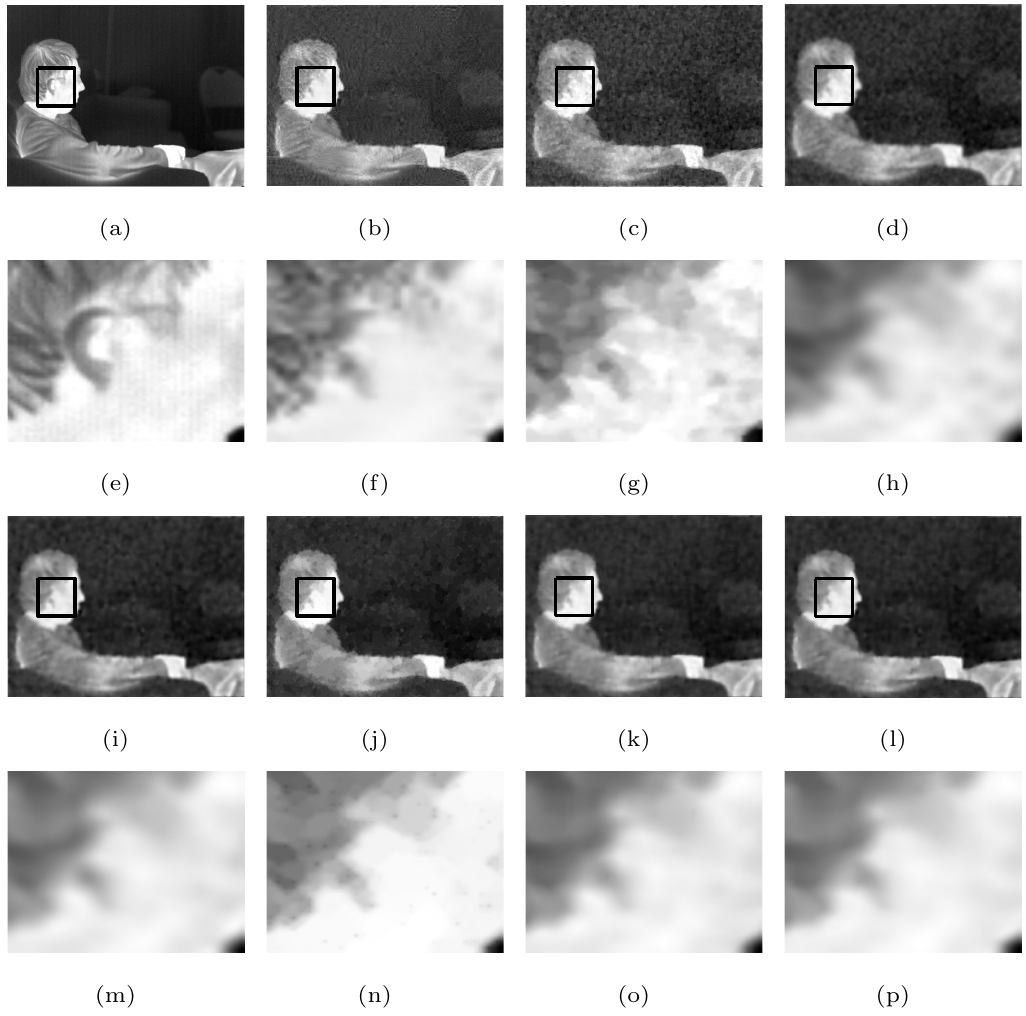
图 1: description of figure Figure 11. Super-resolution x2 results of the LR figure images with added white Gaussian